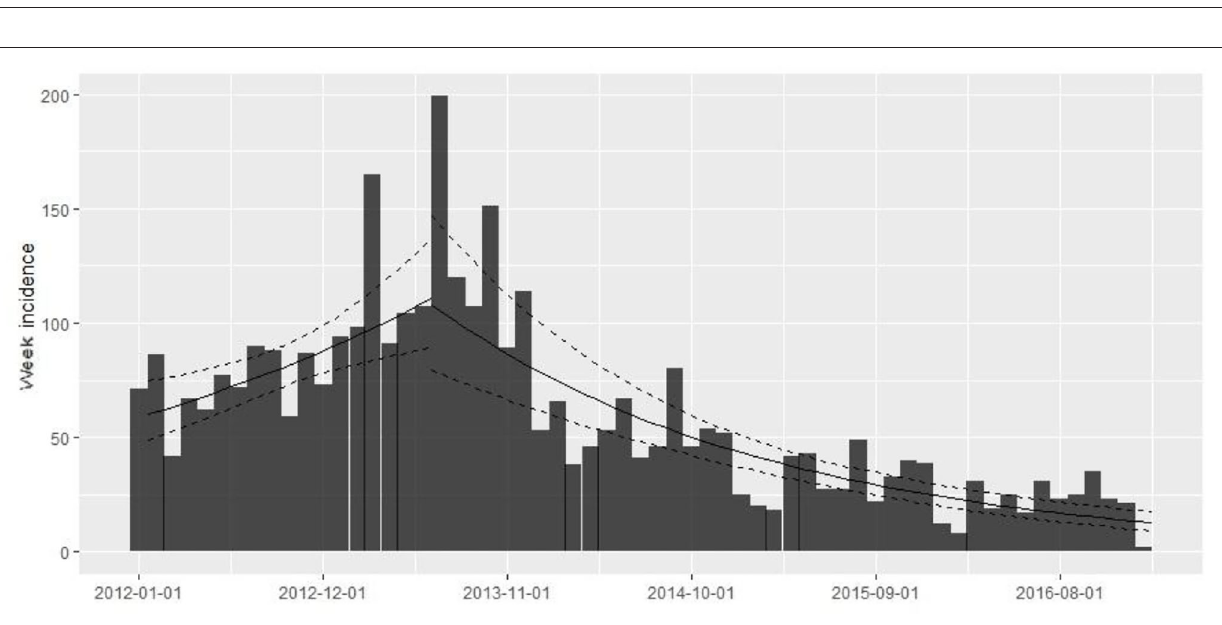
risk), the average weight (significant risk), and the latitude (lower risk), the same effect is observed in both levels of